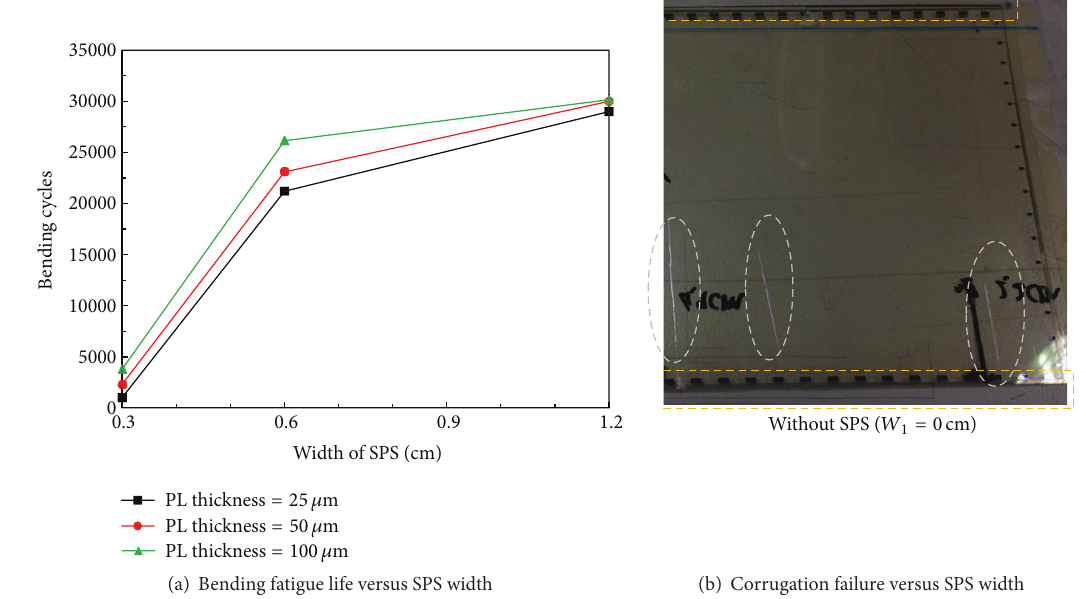
Figure 15: Effects of SPS thickness and width on bending performance of the TDP structure.